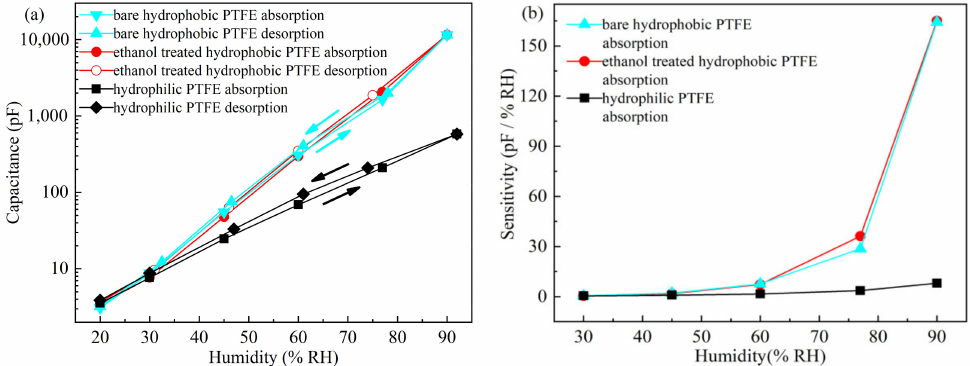
Figure 11. Static test results of the sensors on different substrates: ( a ) hysteresis; ( b )